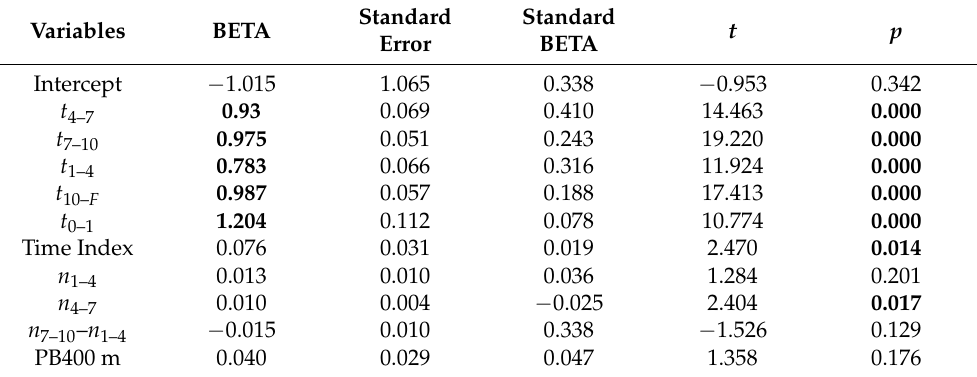
Table 7. Stepwise forward regression coefficients. Parameter of regression model for the dependent variable (T400 mH).